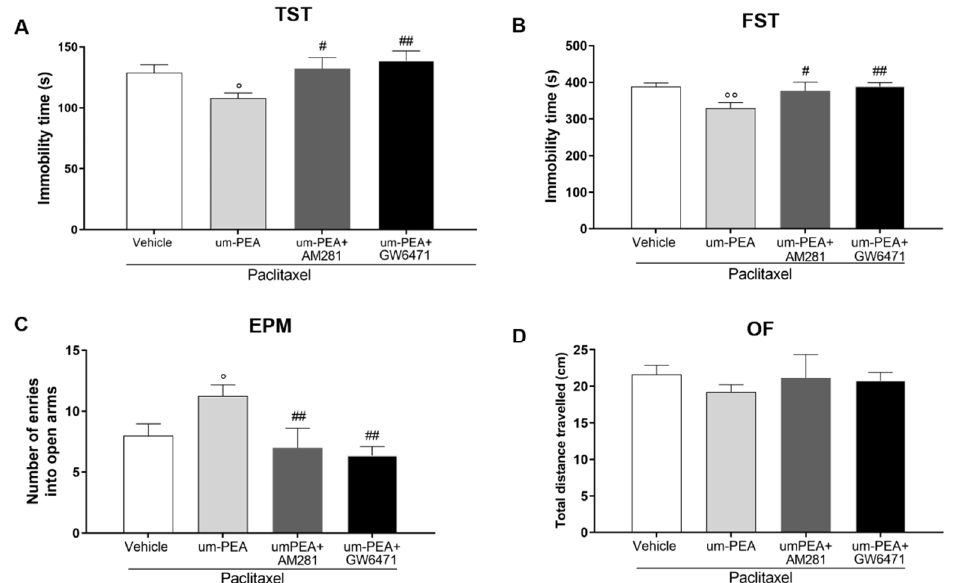
Figure 2. Effect of um-PEA on depressive- and anxiety-like behavior in presence of CB1 or PPAR- α antagonists. ( A ) Time (in seconds) spent immobile in the tail suspension test; ( B ) time (in seconds) spent immobile in the forced swim test; ( C ) number of entries in the open arms of elevated plus-maze test; ( D ) distance travelled (in cm) in the open field test; ° p < 0.05 and °° p < 0.01 versus PTX group; # p < 0.05 and ## p < 0.01 versus PTX+ um-PEA. Data are presented as mean ± SEM ( n = 8). Differences were evaluated by ANOVA followed by Bonferroni’s post hoc test for multiple comparisons.